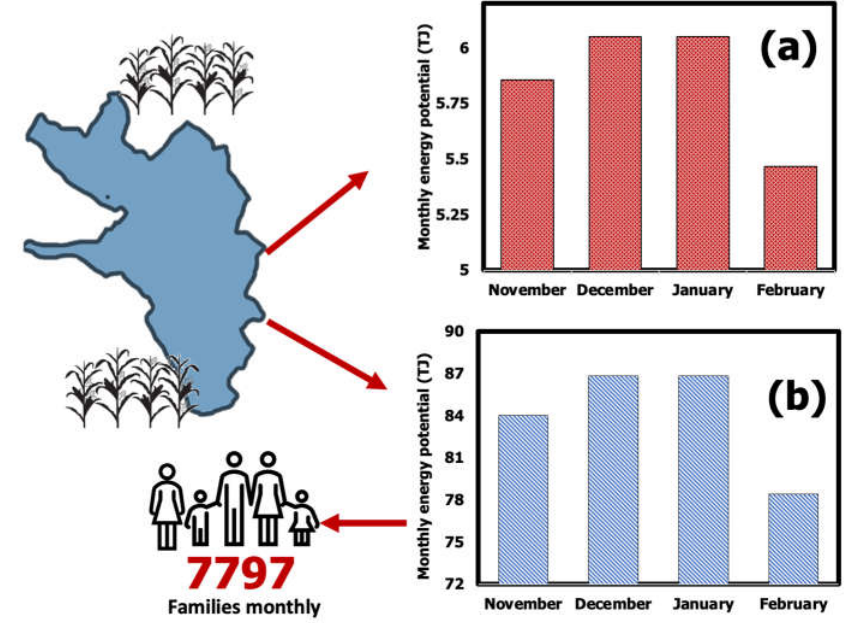
Figure 4. Energy potential of Zea mays residues, in the community of San Francisco Pichátaro: ( a ) in the currently cultivated area ( b ) in the totally available agricultural area.